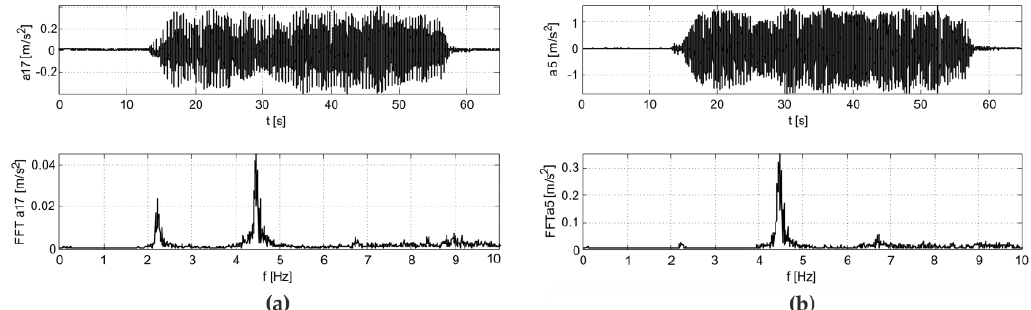
Figure 25. The results of numerical simulations after stand structural tuning from vibrational excitation by the jumping supporters: ( a ) girder, ( b ) roof.